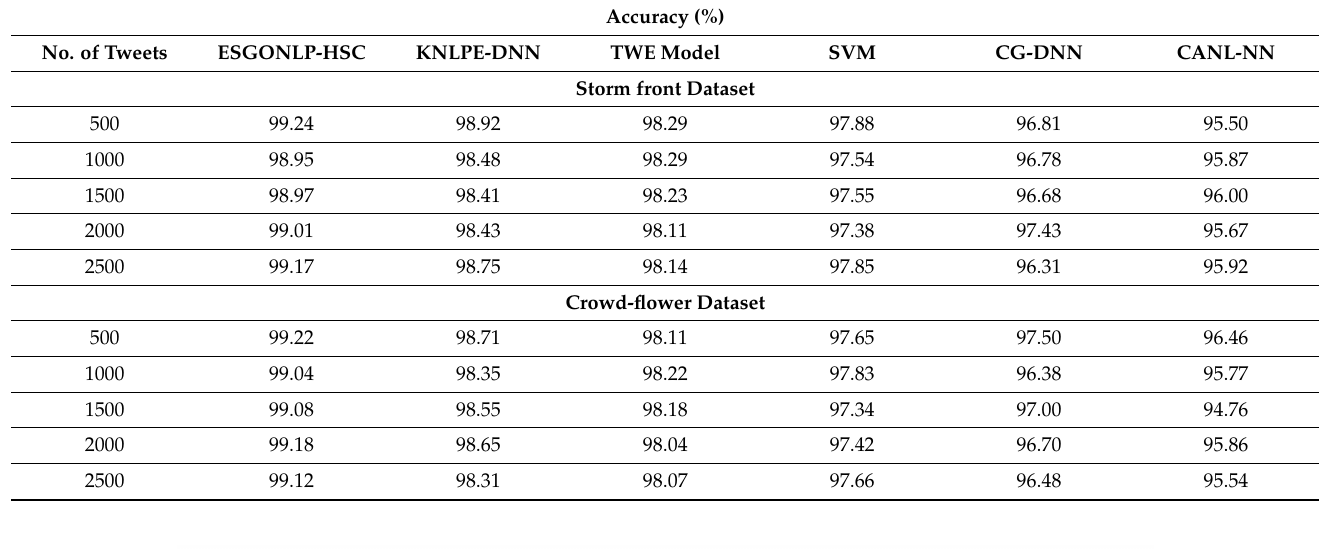
Table 2. Accuracy analysis of ESGONLP-HSC method with the existing approach under Storm front and Crowd-flower datasets.